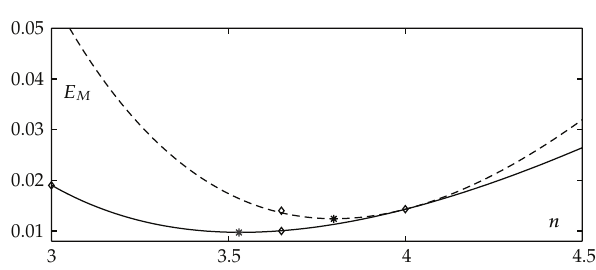
Figure 3: E M (cid:3) n (cid:4) for the constant flux problem, for HBIM (cid:3) solid line (cid:4) and RIM (cid:3) dashed line (cid:4) : errors for n (cid:8) 3 , 3 . 65 , 4 are shown as diamonds and the minimum errors are shown as asterisks